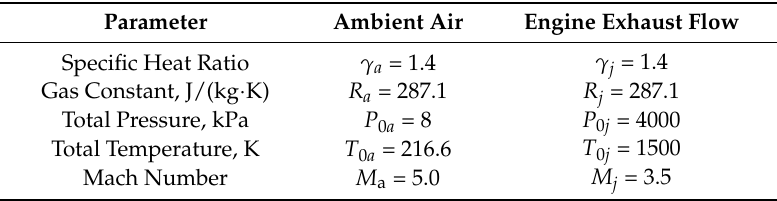
Table 1. Summary of flow